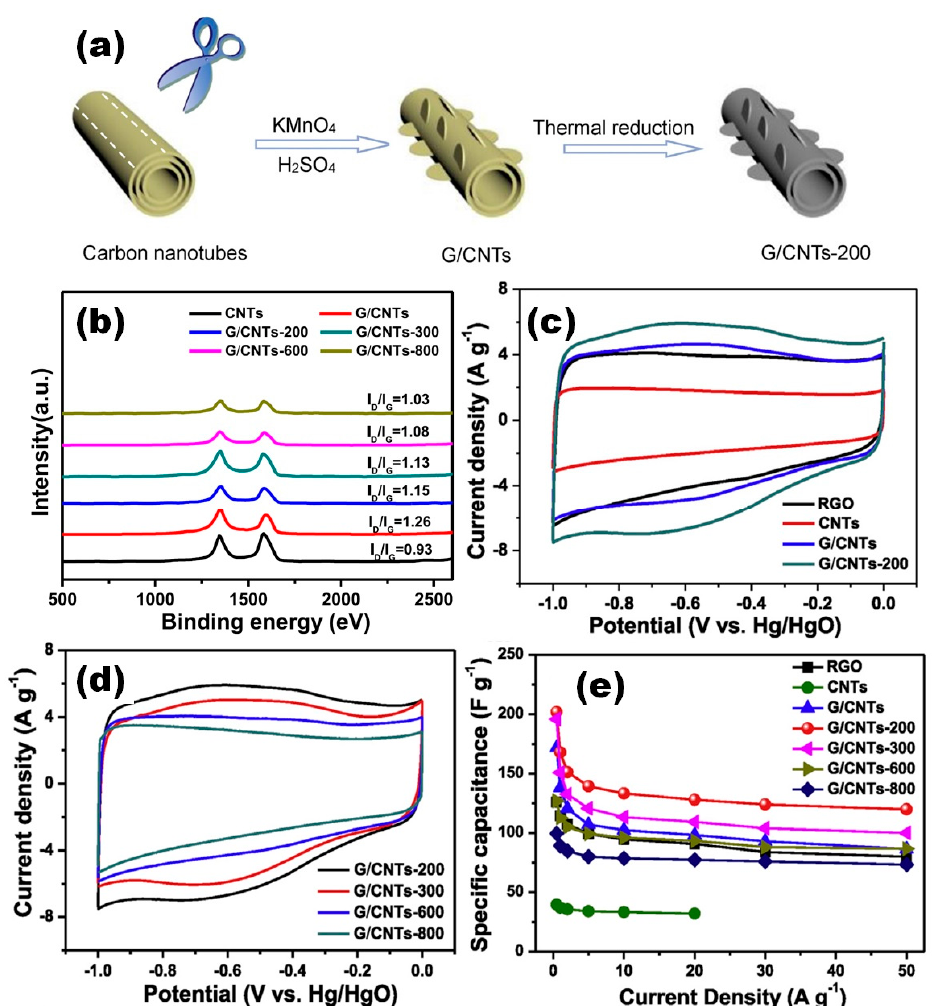
Figure 6. Schematic illustration of the synthetic route of reduced graphene oxide with carbon nanotubes (mentioned here as G/CNTs) after annealing at 200 °C (G/CNTs-200) ( a ). Raman spectra of studied electrodes ( b ). CV curves measured at 50 mV/s on rGO, CNT, G/CNT and G/CNTs-200 ( c ), as well as G/CNT annealed at 300, 600 and 800 °C (G/CNTs-300, G/CNTs-600, and G/CNTs-800, respectively) ( d ). Specific capacitance of rGO, CNTs, G/CNTs, G/CNTs-200, G/CNTs-300, G/CNTs-600 and G/CNTs-800 as a function of current density ( e ) (Reproduced with permission of [21]. Copyright Else- vier, 2018).